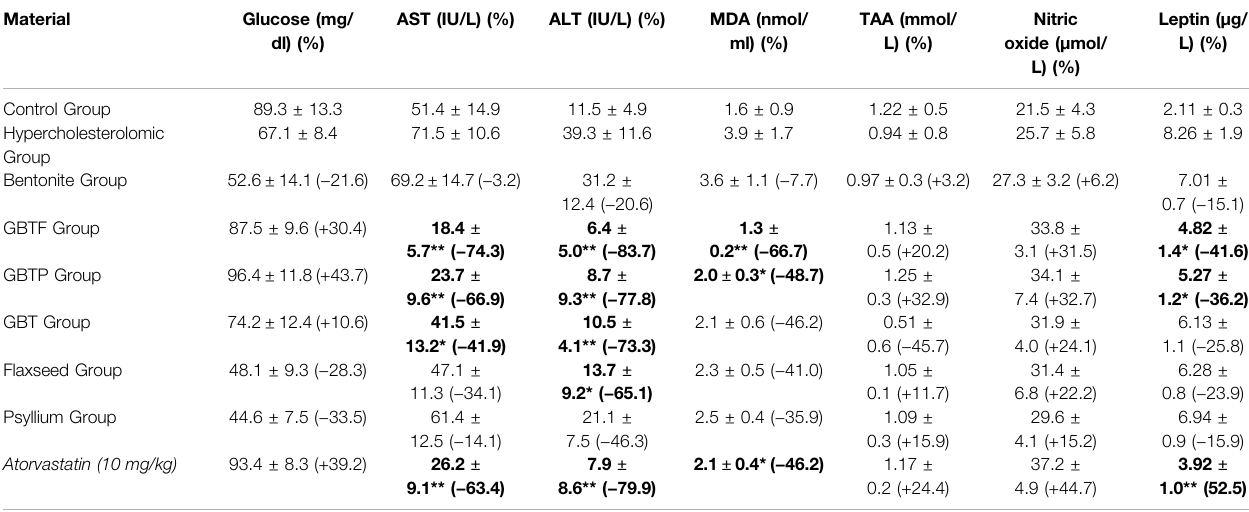
TABLE 4 | Effects of test materials on serum Glucose, AST, ALT, MDA, TAA, Nitric oxide, and Leptin. Material